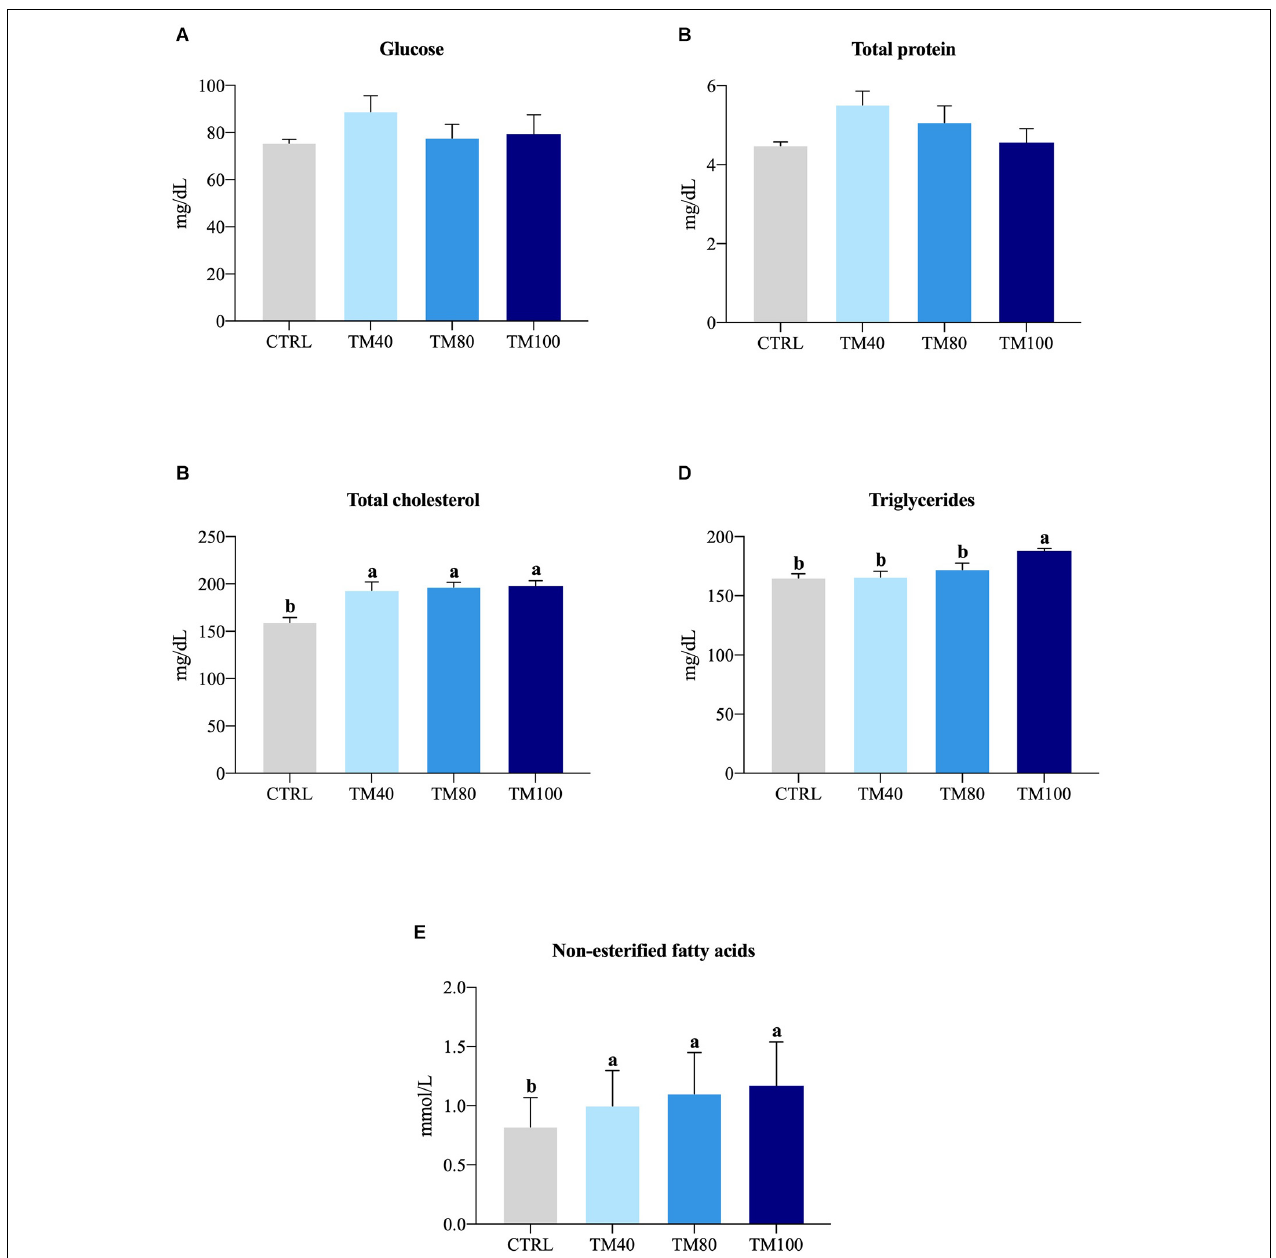
FIGURE 3 | Plasma glucose (A) , total protein (B) , total cholesterol (C) , triglycerides (D) and non-esterified fatty acids (E) of European sea bass fed experimental diets. Bars represent means ± SEM; n = 15 (5 fish/replicate). Labeled means without a common superscript letter differ significantly, p <